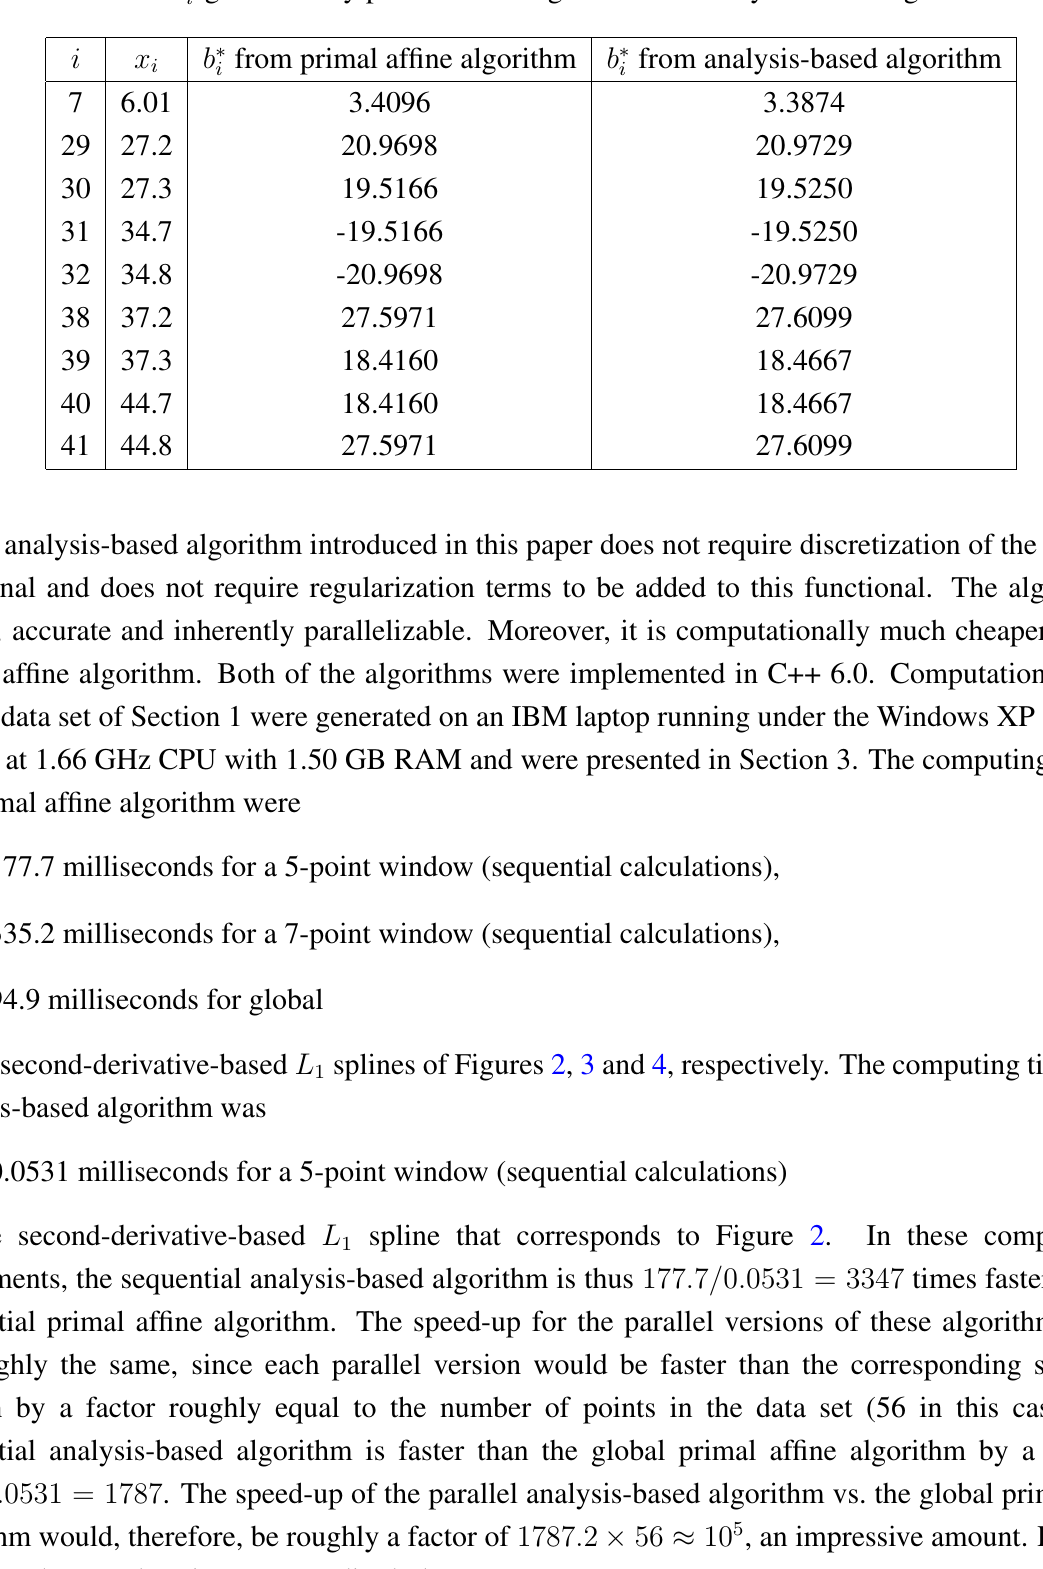
Table 2 . b ∗ generated by primal affine algorithm and analysis-based i